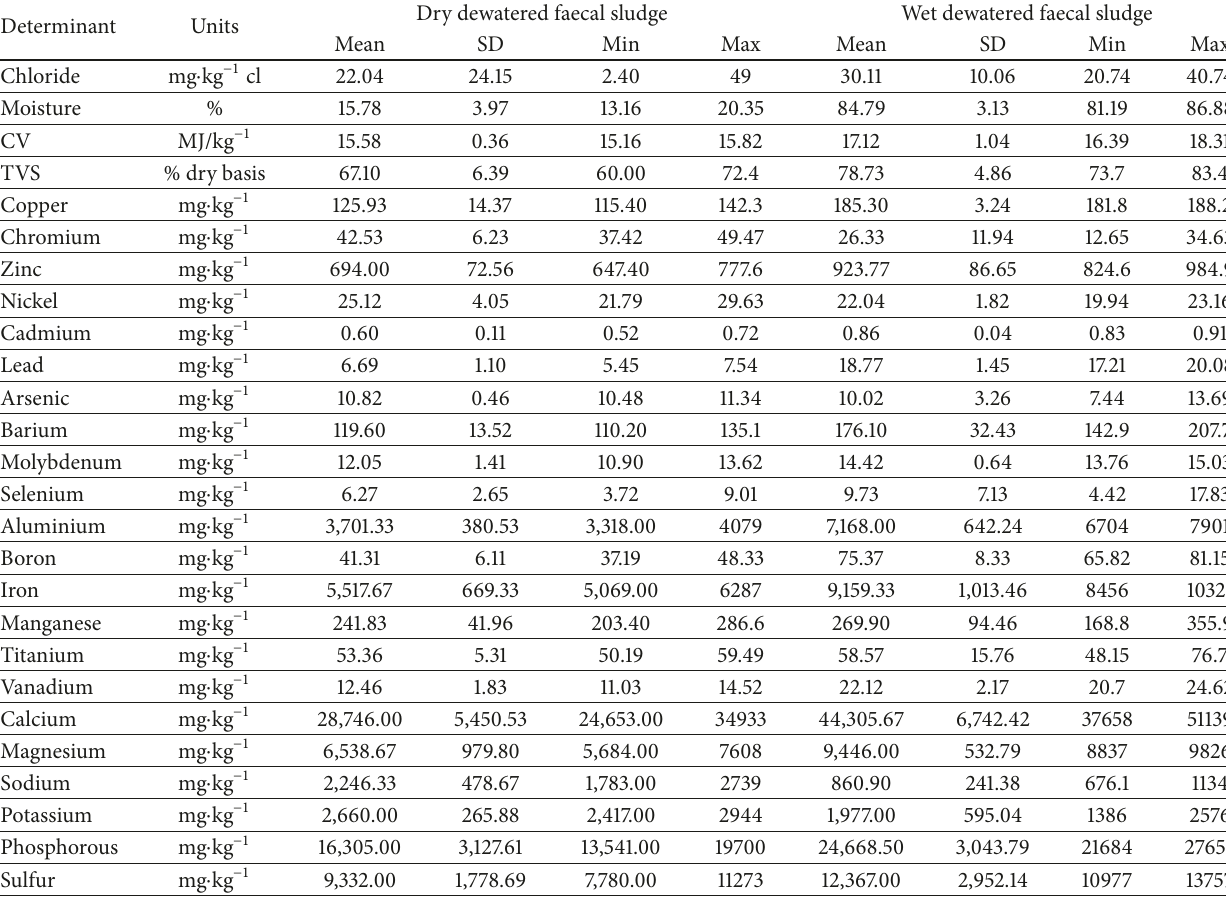
Table 5: Summary physicochemical parameters for both wet and dried dewatered solid sludge.